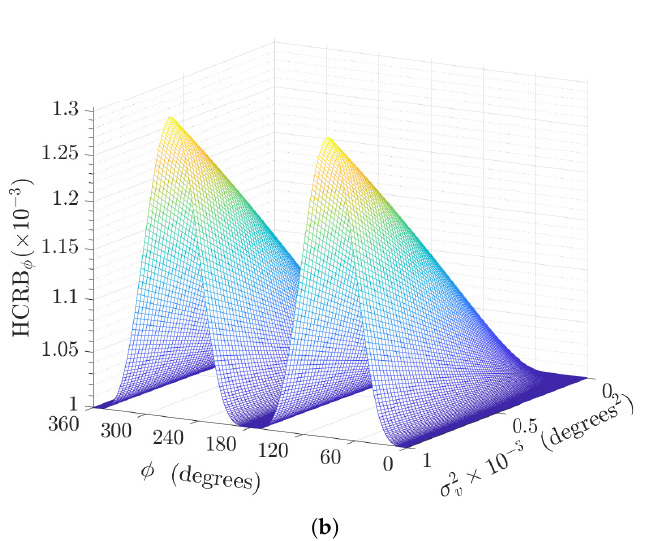
Figure 6. Plot of HCRB φ versus the directions-of-arrival for the azimuth angles and ( a ) polar angle θ ∈ [ 0,90 ◦ ] ( σ v = 0.0873 radian), and ( b ) skew angle variance σ 2 σ 2 s / σ 2 n = 5.